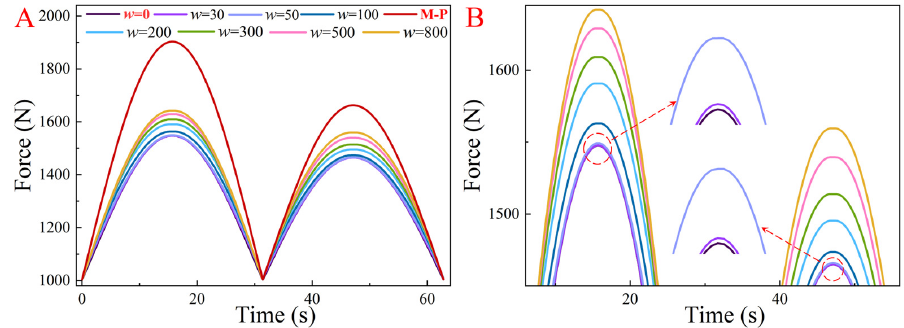
Figure 8. Driving force optimization results ( M = 1, N = 2) using different optimization methods: ( A ) overall view and ( B ) partial enlarged view.